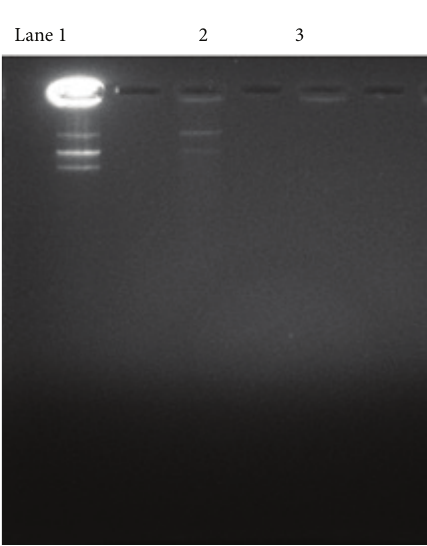
Figure 3: DNA integrity study by gel retardation assay. Lane 1: pDNA control and Lane 2: PLGA:A1(85 : 15) 3-PLGA